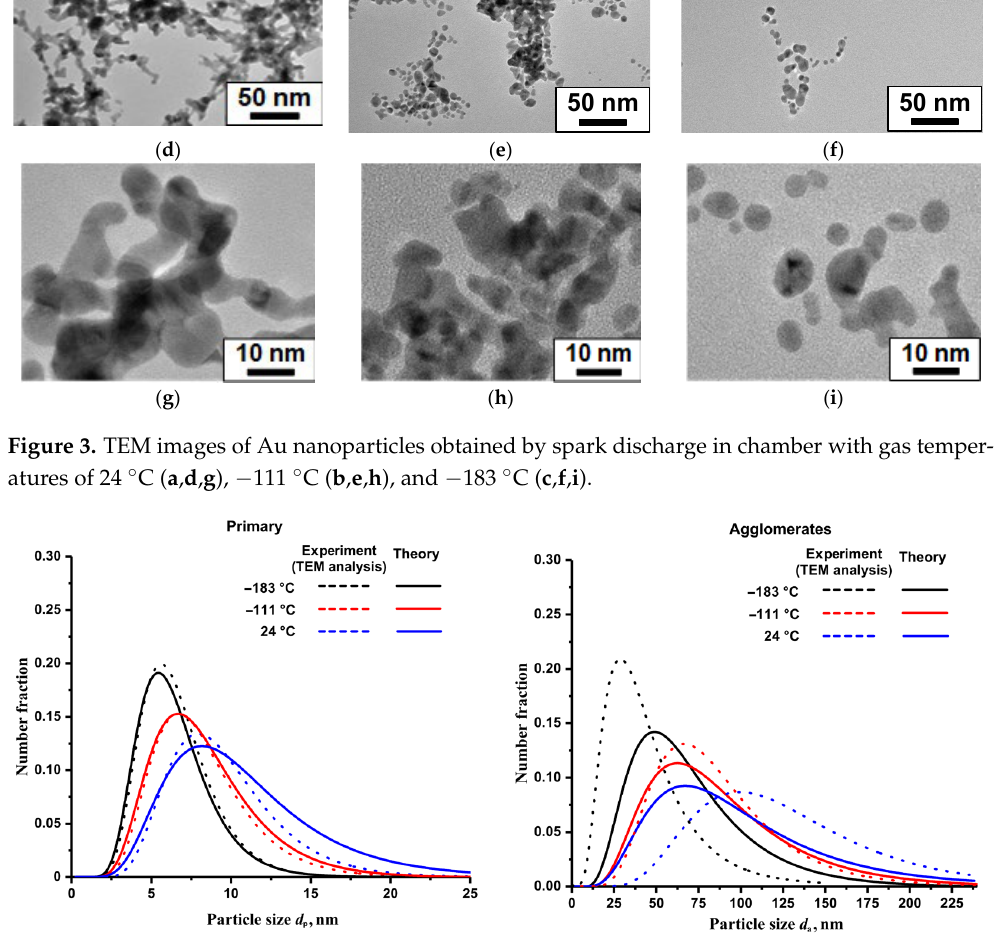
Table 3. Mass production of the synthesis of Au nanoparticles depending on the temperature of the carrier gas (nitrogen).